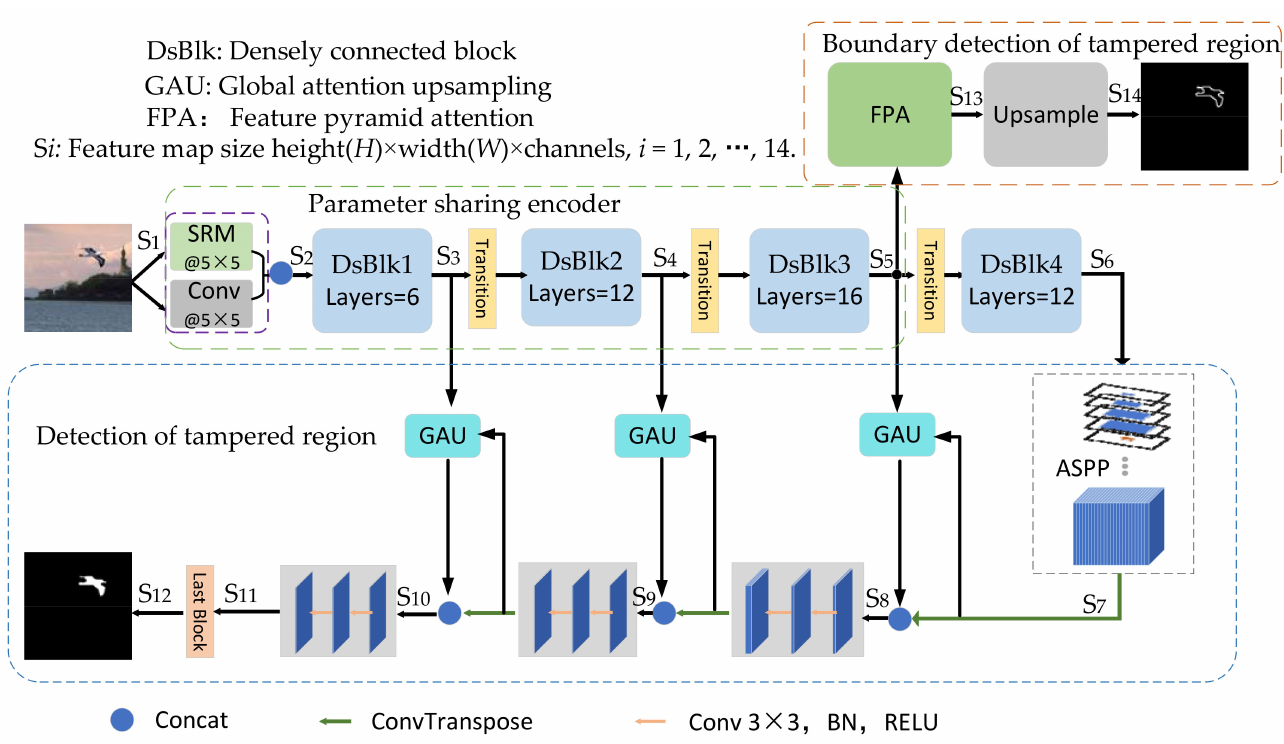
Figure 2. Proposed tampering detection model outline (S1: H × W × 3, S2: H × W × 64, S3: H × W × 136, S4: H /2 × W /2 × 212, S5: H /4 × W /4 × 298, S6: H /8 × W /8 × 293, S7: H /8 × W /8 × 453, S8: H /4 × W /4 × 751, S9: H /2 × W /2 × 512, S10: H × W × 256, S11: H × W × 64, S12: H × W × 1, S13 = S5, S14 =